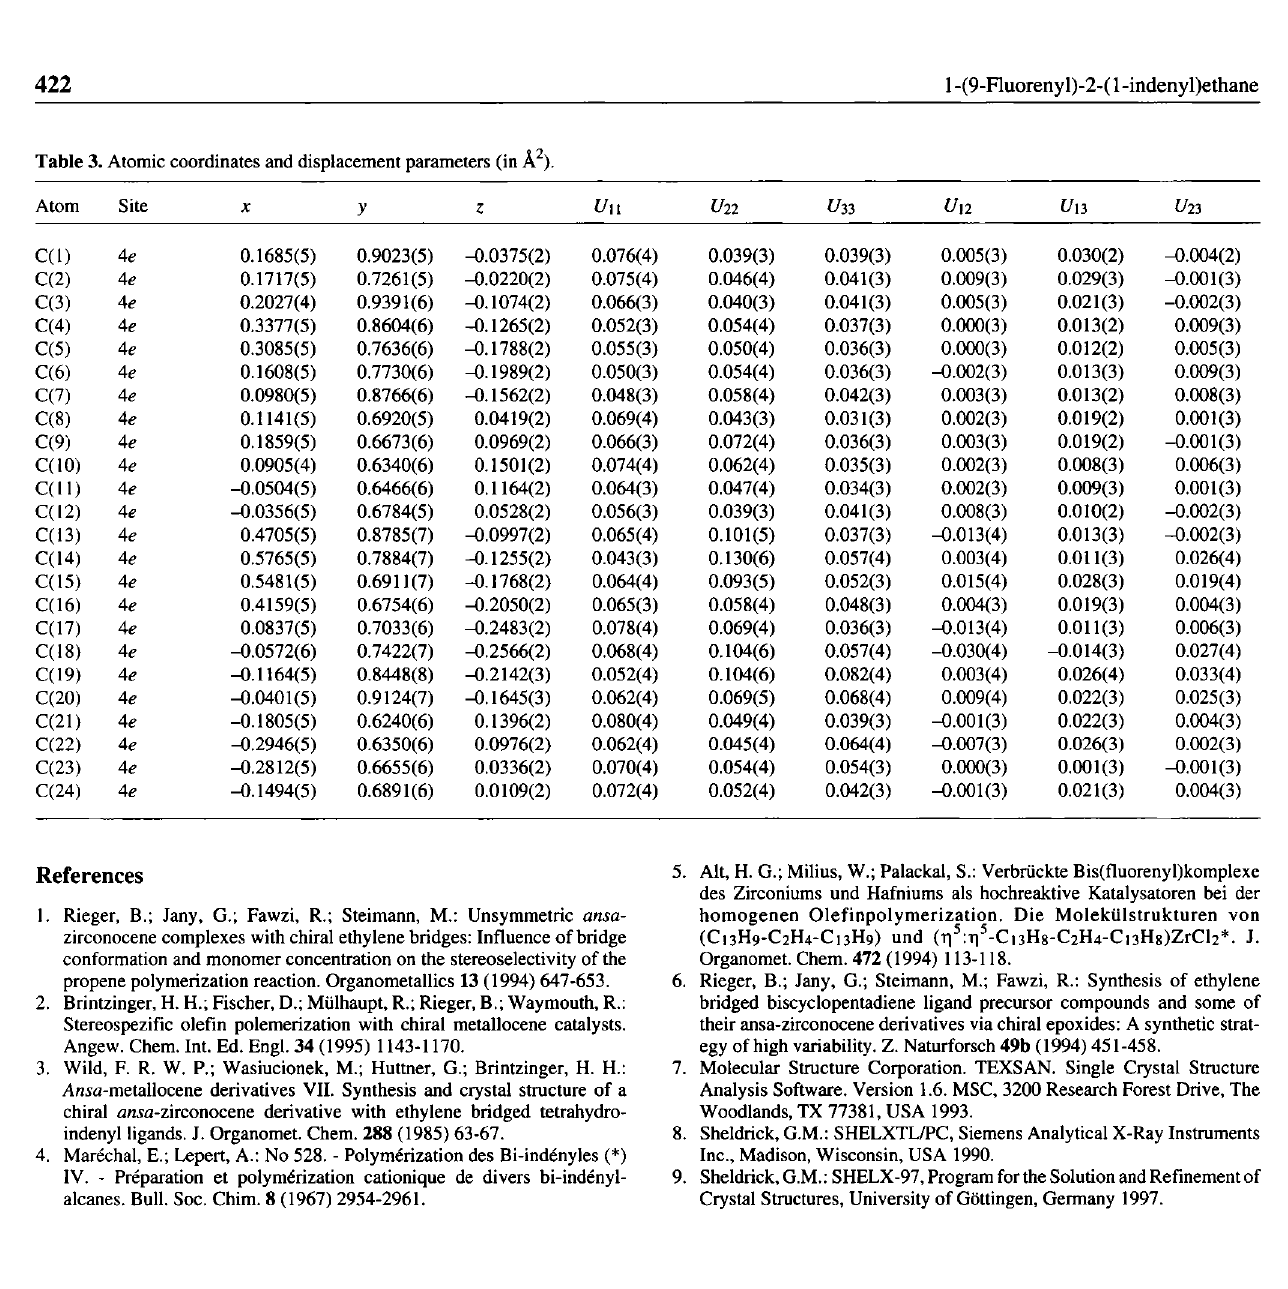
Table 3. Atomic coordinates and displacement parameters (in Ä 2